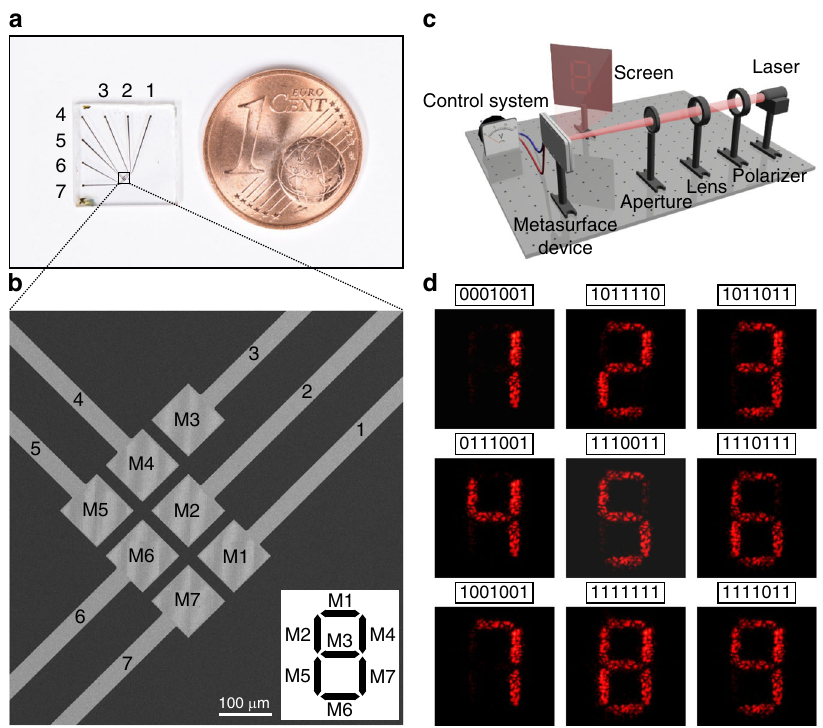
Fig. 4 Numeric indicator display generated by the electrically-controlled DMSD. a Photograph of the DMSD next to a 1 cent euro coin. b SEM image of the DMSD with seven metasurface pixels, independently controlled by addressable electrodes. Inset: relation between each metasurface pixel and the corresponding holographic pattern for the numeric indicator display. c Schematic of the optical setup. d Experimental results. Different numbers corresponding to 7-bit optical information are dynamically generated by the DMSD.